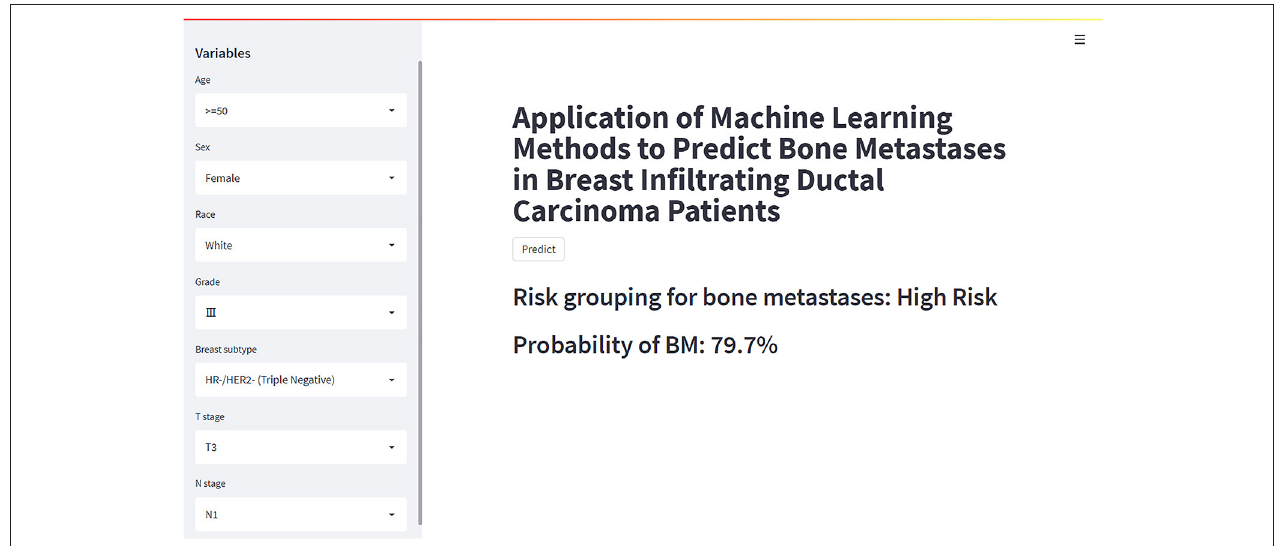
FIGURE 7 | The web calculator for predicting bone metastases in breast infiltrating duct carcinoma patients. (52). Of course, they always had the final decision when it came to interpretation based on their domain